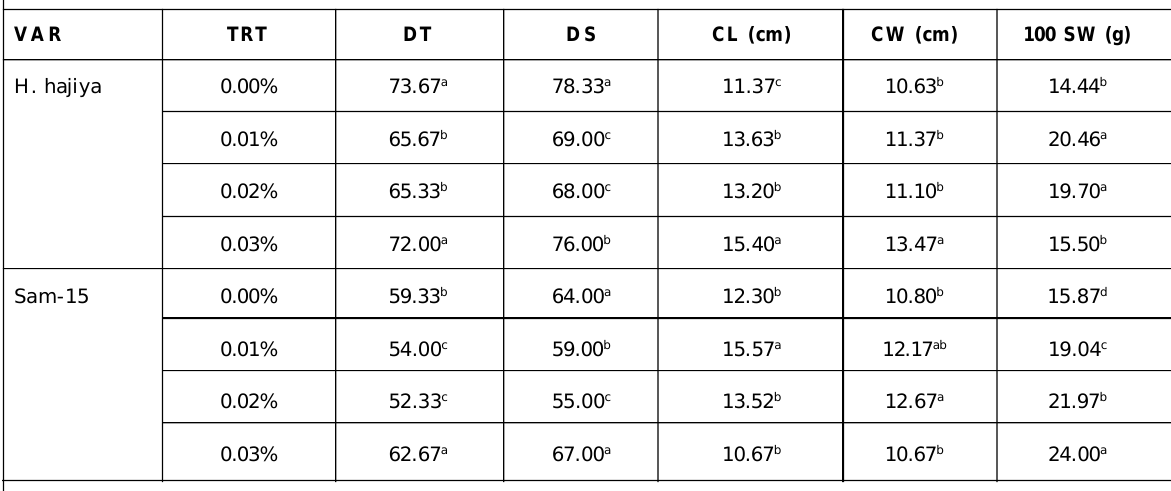
Table 3: Effects of sodium azide on days to tasseling, sulking and some yield parameters VAR TRT DT DS CL (cm) CW (cm) 100 SW (g) H. hajiya 0.00% 73.67 a